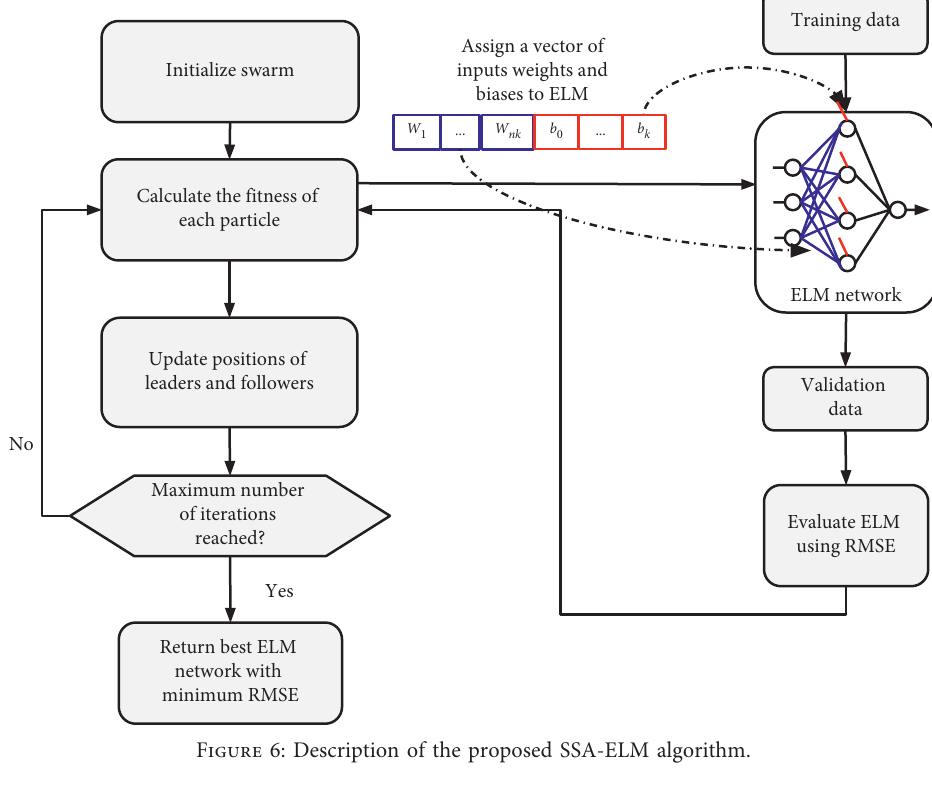
Figure 6: Description of the proposed SSA-ELM algorithm.